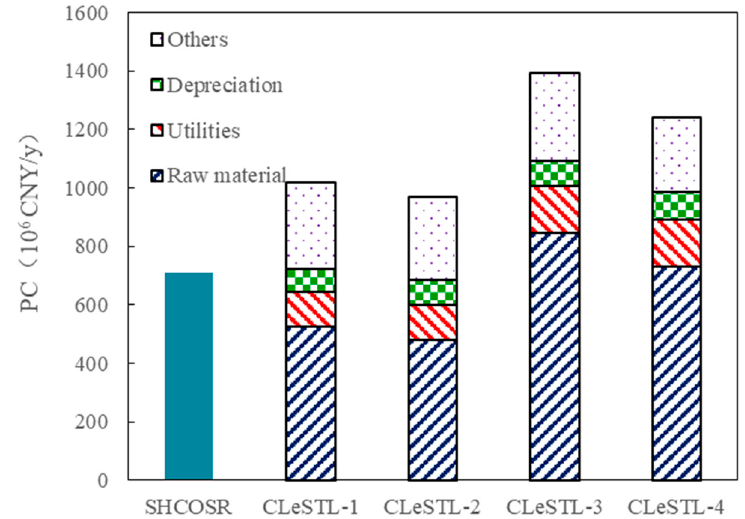
Figure 16. Distribution of production cost for CLeSTL with different scenarios.